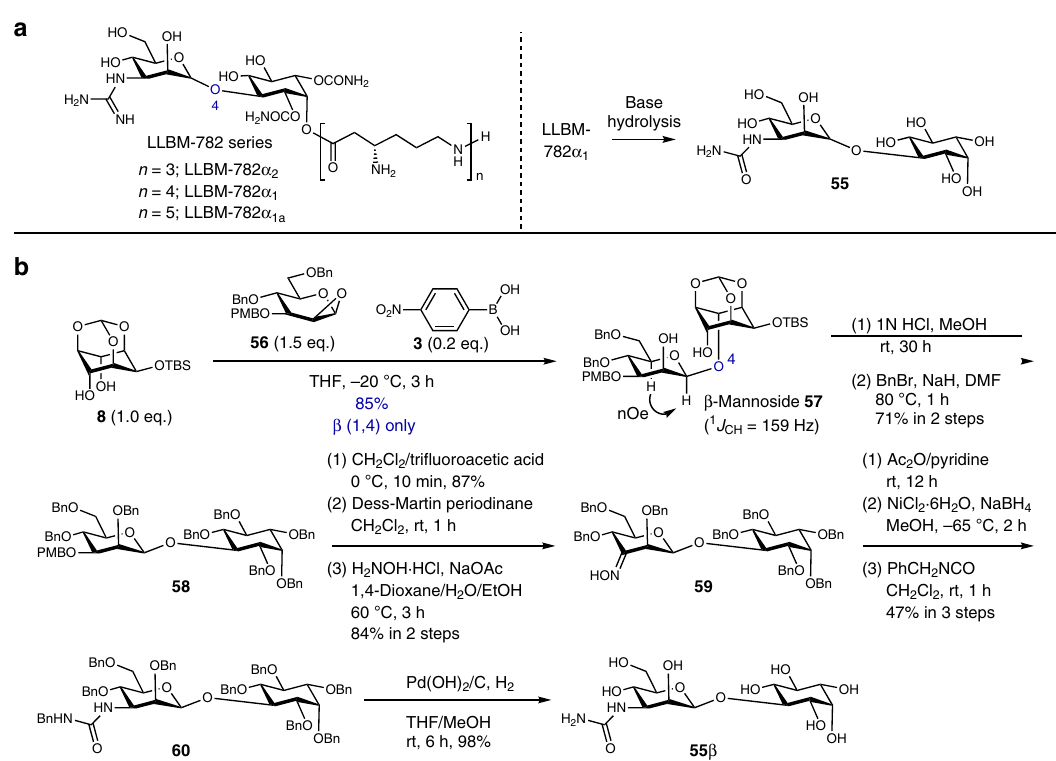
Fig. 8 Synthetic scheme of mannoside 55 β . a Chemical structures of LLBM-782 series and mannoside 55 produced by base hydrolysis of LLBM-782 α 1 . b Synthesis of mannoside 55 β using the present glycosylation method. PMB p -methoxybenzyl, DMF (Supplementary Figs. 28 and 29, Supplementary Tables 26 and